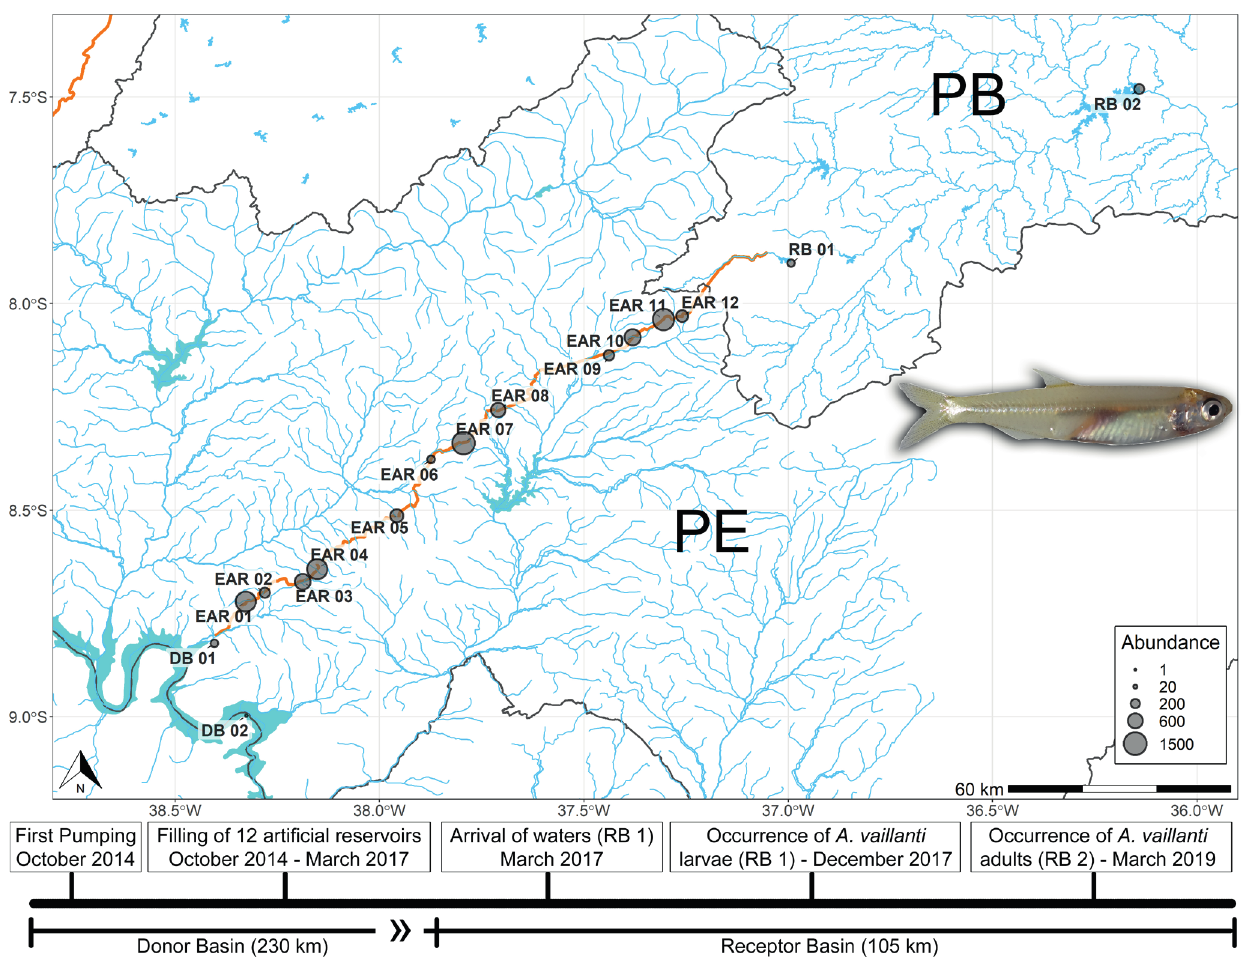
FIGURE 5 | Spatial distribution of Anchoviella vaillanti. The size of the circles represents juveniles/adults’ abundance at each sampling site. The species went from the Sao Francisco donor basin through the SF-IWT East Axis artificial canals and reservoirs, reaching the receiving Paraíba do Norte basin sites, in the states of Pernambuco (PE) and Paraíba (PB), Brazil. DB = Donor basin, EAR = East Axis Reservoirs, RB = Receiving basin. Detailed location list of the sampling sites in Tab. S1